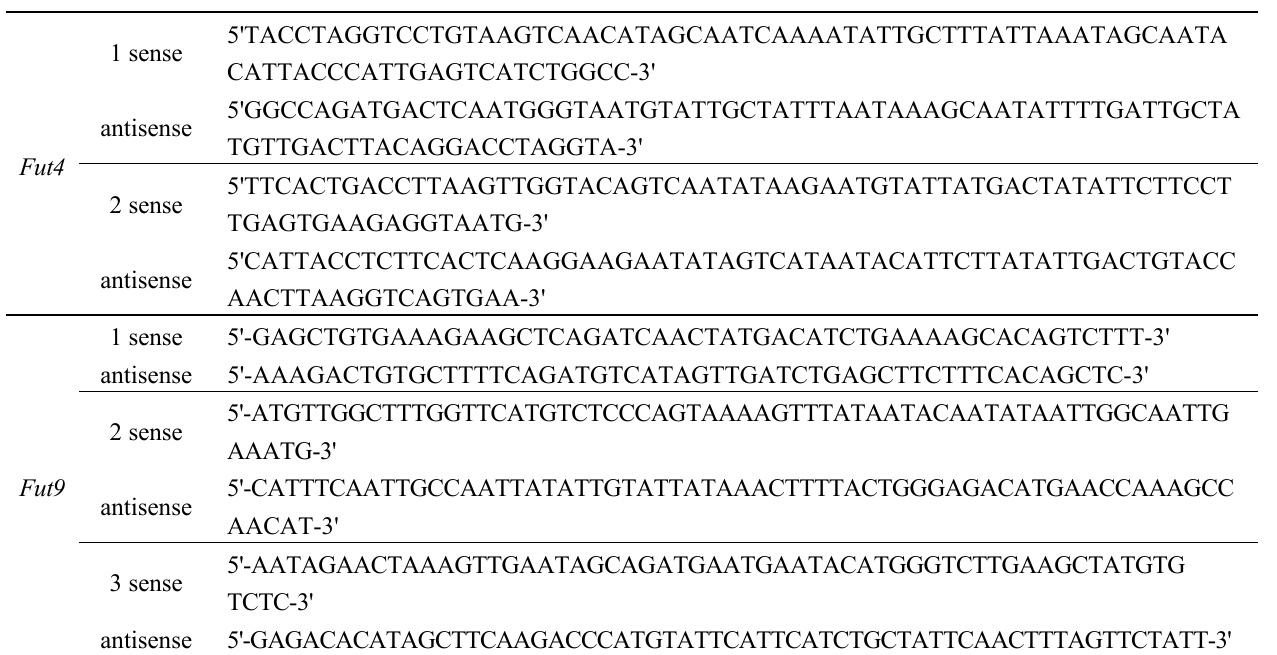
Table 4. Primers for Fut4 and Fut9